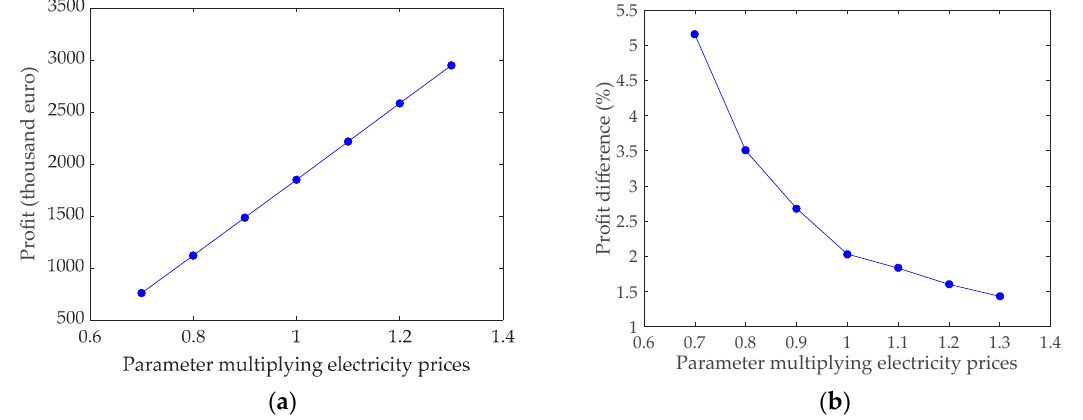
Figure 19. Sensitivity analysis: spark price. ( a ) Expected profit considering storage, ( b ) difference between the profits of cases with and without storage.